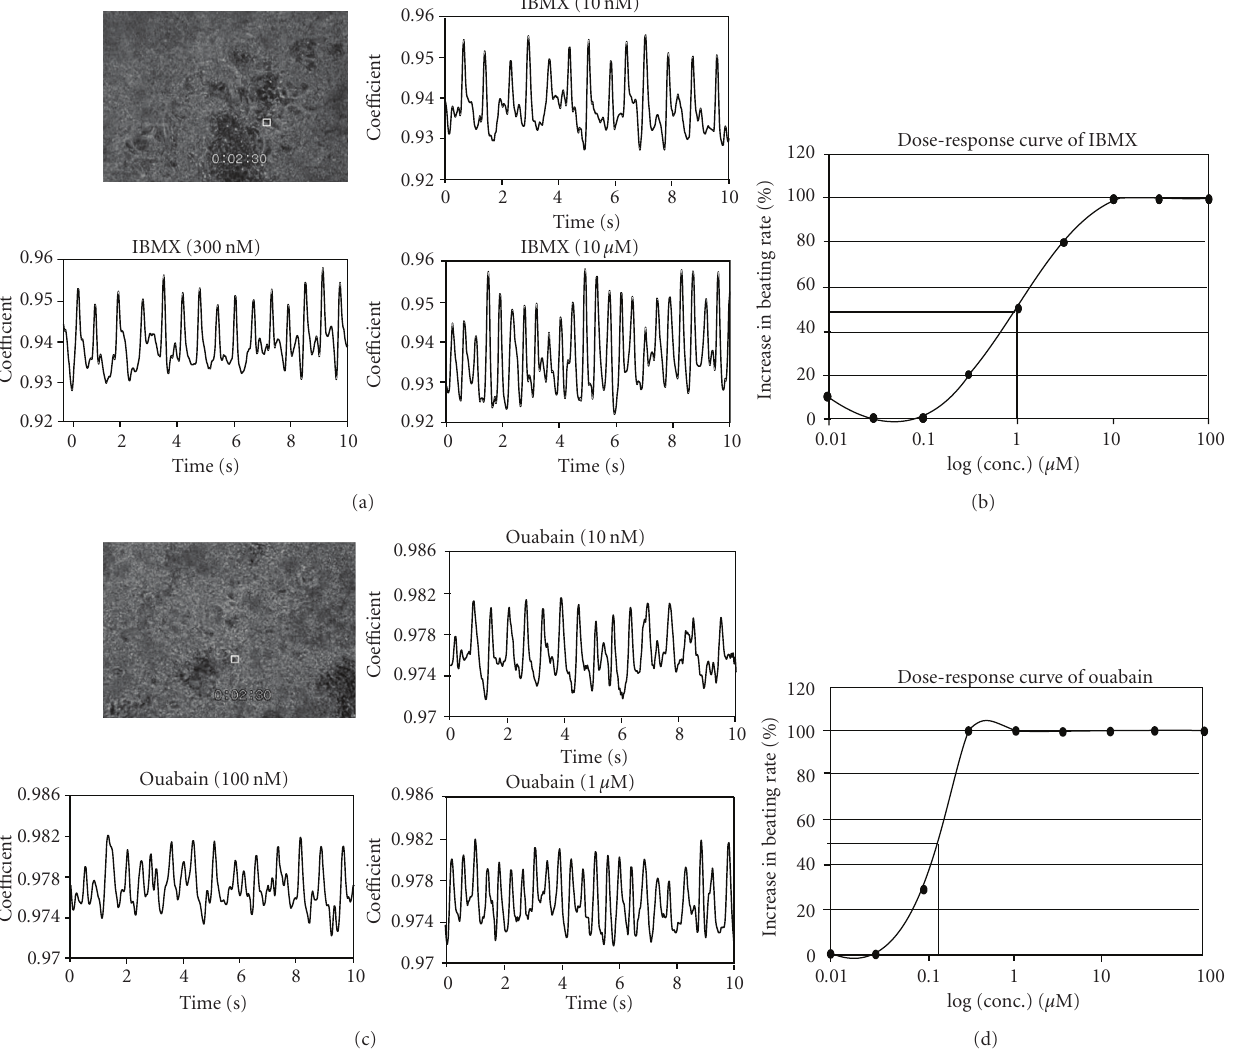
Figure 4: The pharmacological reactions of the P19CL6-A1-derived cardiomyocytes. The contraction rhythms of the beating cells are analyzed on the moving images before and after addition of the serial dilutions of IBMX (a) and ouabain (c) using the VisoRhythm software on which the temporal variations in the correlation coe ffi cient are calculated between the values of mean brightness of the reference frame and those of other frames in the selected area (20 × 20 pixels in white), and accordingly, the correlograms representing the contraction rhythm of the beating cells are displayed by the vertical coe ffi cient and horizontal time axis. ((b) and (d)) The median e ff ective doses (ED 50 ) of IBMX (b) and ouabain (d) obtained from the dose-response curve based on the beating rates, on which the basal and maximum rates are represented by 0 and 100%, are 950 nM and 160 nM,